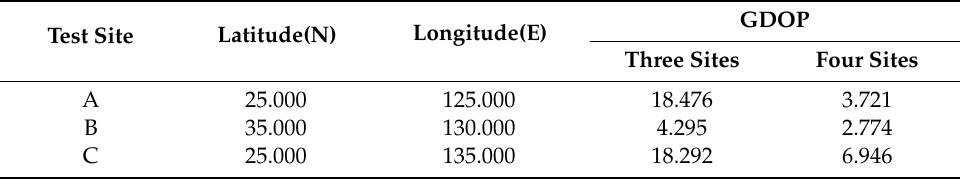
Figure 6. The GDOP of user based on azimuth, the left one is for three sites and the right one is for four sites. Table 2. The GDOP of user sites.